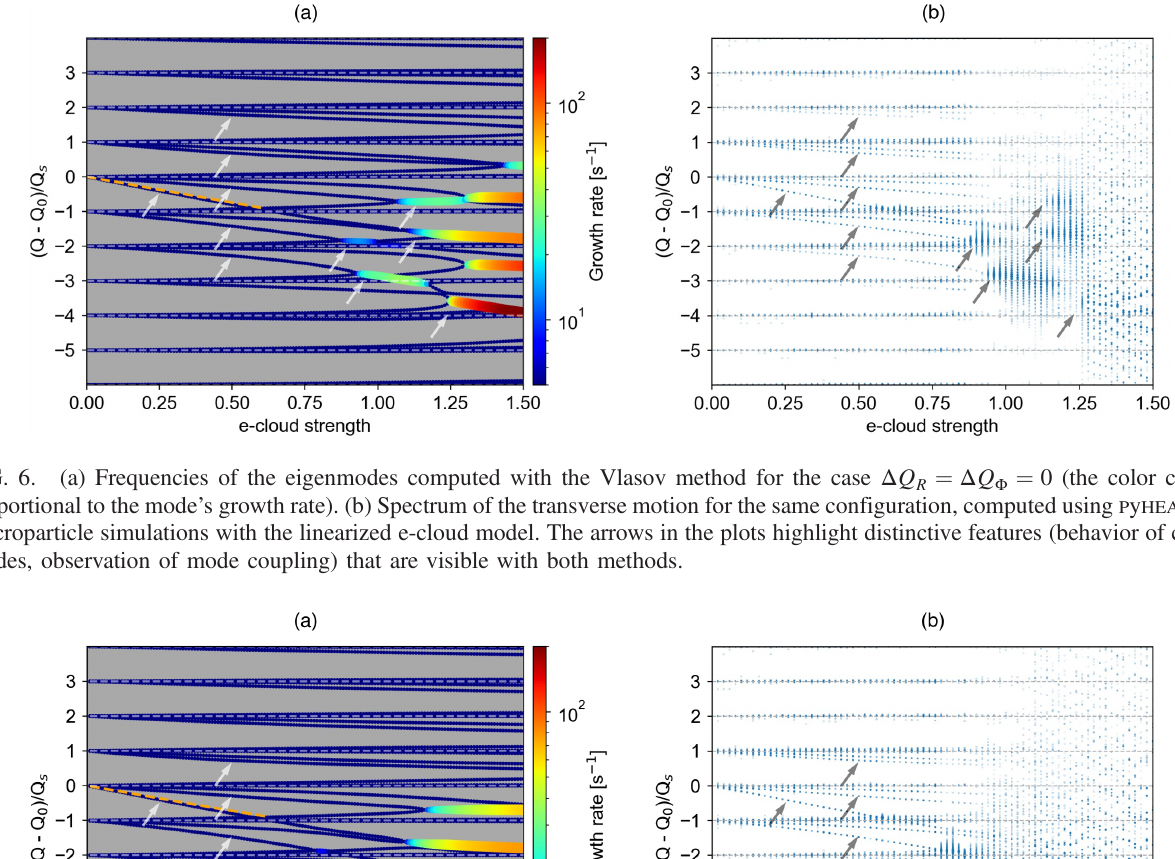
model).FIG. 7. Same as Fig. 6 for the case Δ Q (linearized e-could